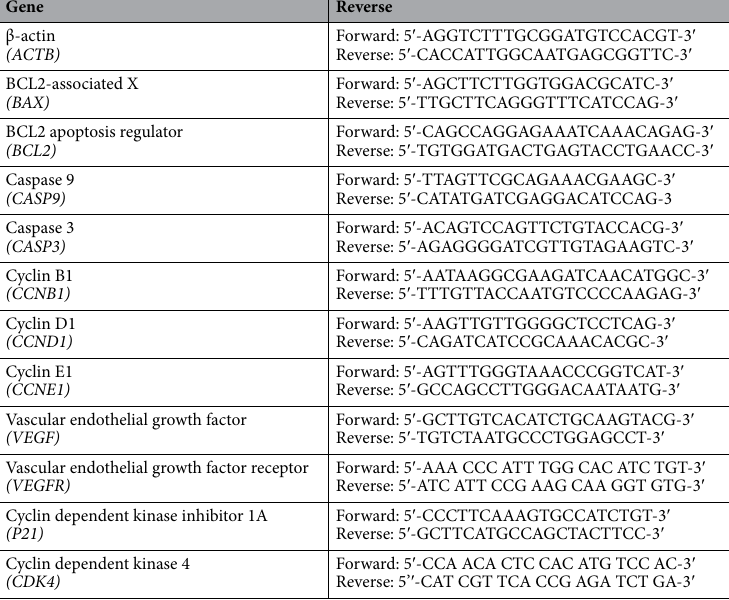
Table 1. The utilized primers in this